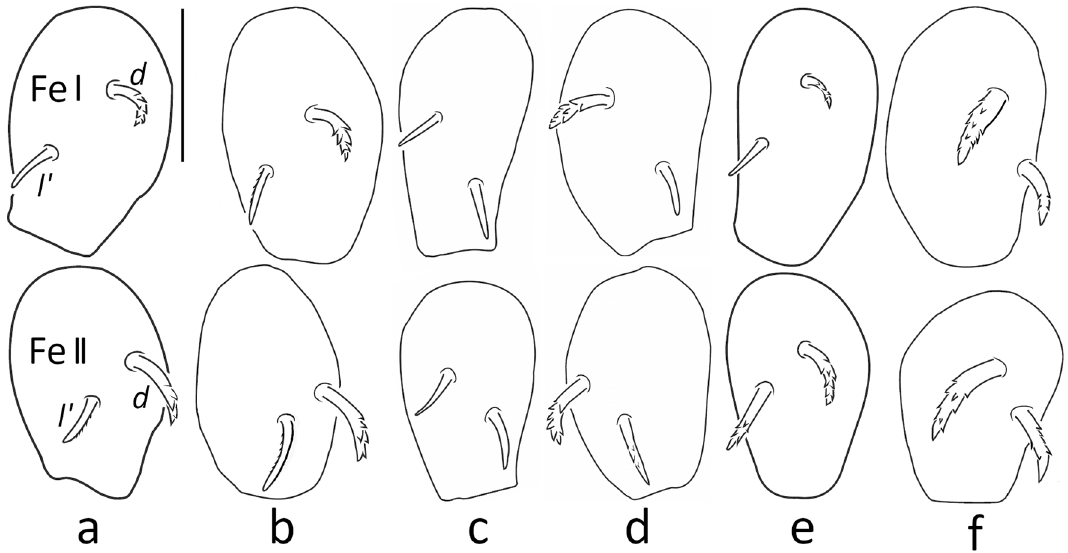
Figure 4. Comparison of dorsal setation of femora I and II (proximal parts of femora not drawn). ( a ) Caleremaeus mentobellus , ( b ) C. lignophilus , ( c ) C. elevatus , ( d ) C. alpinus , ( e ) C. hispanicus and ( f ) C. monilipes ; scale bar = 25